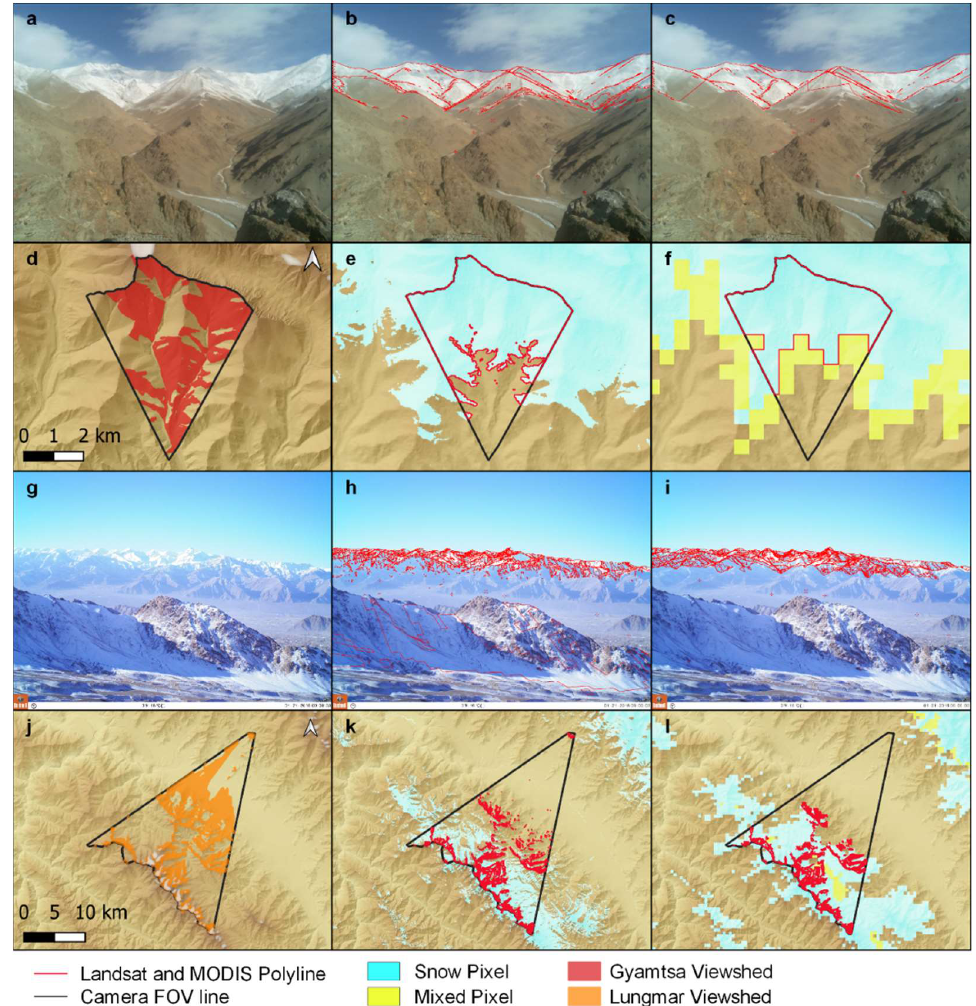
Figure 4. Terrestrial photograph taken from Gyamtsa on 23 January 2017 ( a ), overlaid with snow polylines (red lines) and control points (red crosses) derived from Landsat-8 OLI image ( b ) and MODIS ( c ). Gyamtsa camera view shed in red colour ( d ). Landsat-8 OLI ( e ) and MODIS snow shown in cyan ( f ). Terrestrial photograph taken from Lungmar on 21 January 2016 ( g ), overlaid with snow polylines (red lines) derived from Landsat-8 OLI ( h ) and MODIS ( i ). Lungmar view shed in orange colour ( j ). Landsat-8 OLI ( k ) and MODIS snow ( l ).